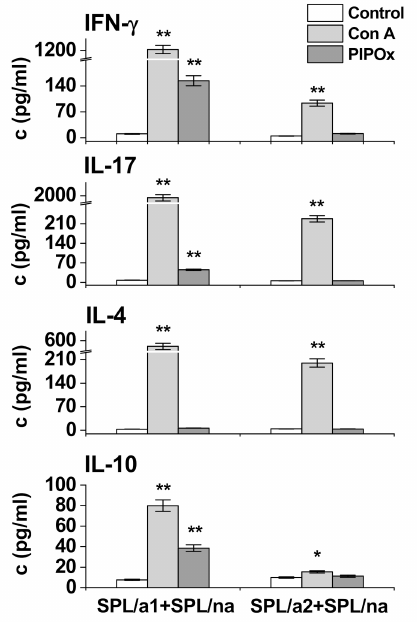
Figure 4. Production of cytokines after in vitro co-stimulation. Concentration of IFN- γ , IL-17, IL-4 and IL-10 in media after co-stimulation of non-adherent spleen cells with stimulated adherent spleen cells obtained after the 1st (SPL/a1) and the 2nd (SPL/a2) adherence period. Response to stimulation with Con A (10 µ g/mL) and PIPOx (5 mg/mL). As a negative control, media of unstimulated cells were used. Tests were carried out in triplicate. The experimental data are expressed as geometric means of three replicates ± SD. Levels of significance: ** 0.001 < p < 0.01, * 0.01 < p < 0.05. Differences were considered significant at 0.01 < p < 0.05.